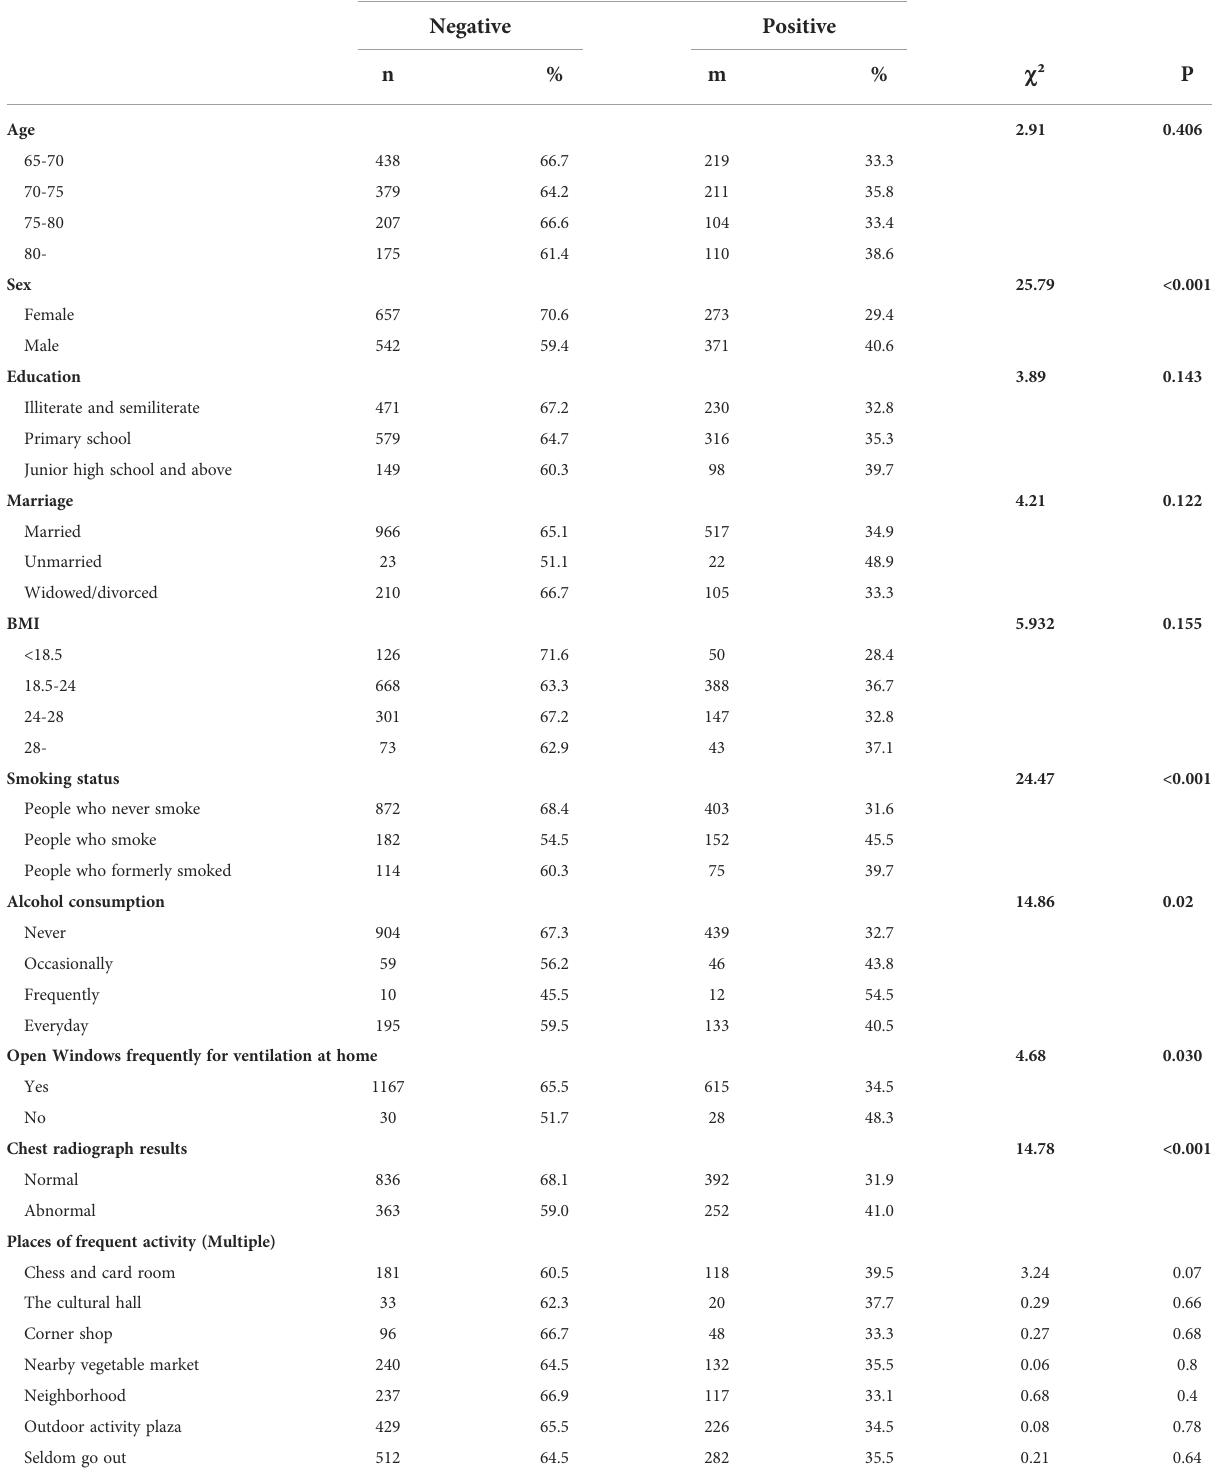
TABLE 2 The relationships between participant characteristics and latent tuberculosis infection in the study.